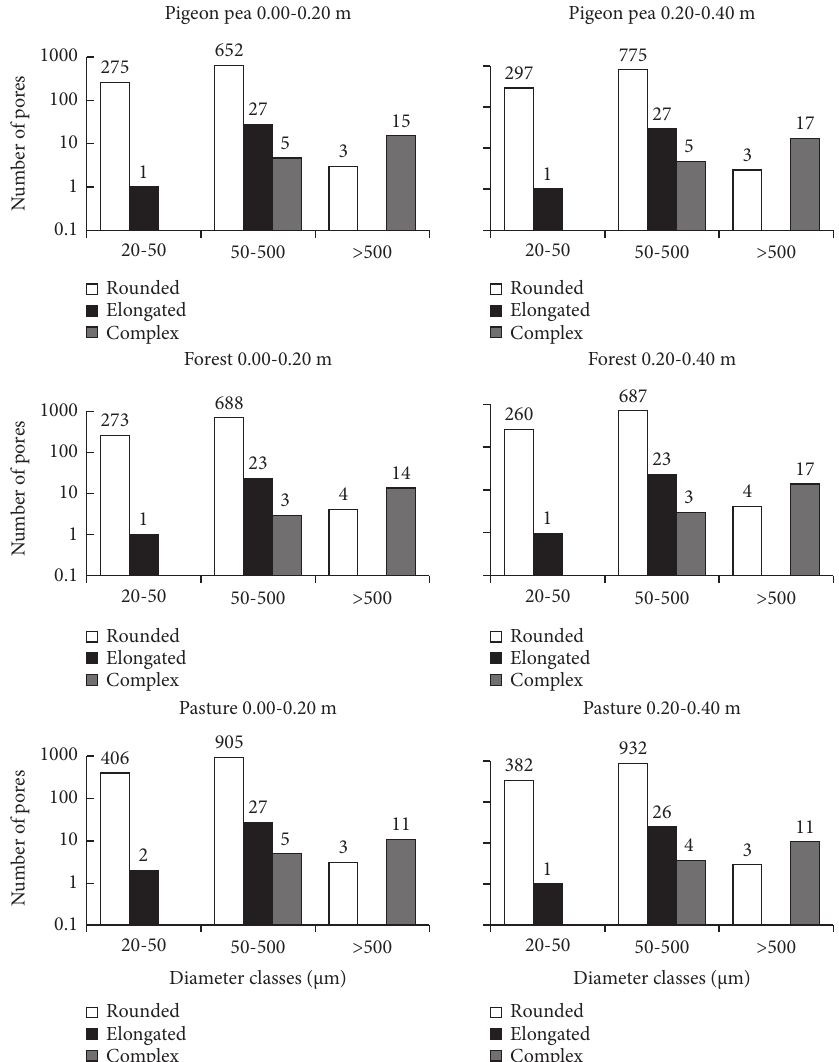
Figure 3: Number of pores according to shape and size from ADE areas with pigeon pea, pasture, and native forest, in soil layer ranges of 0.00–0.20m and 0.20–0.40